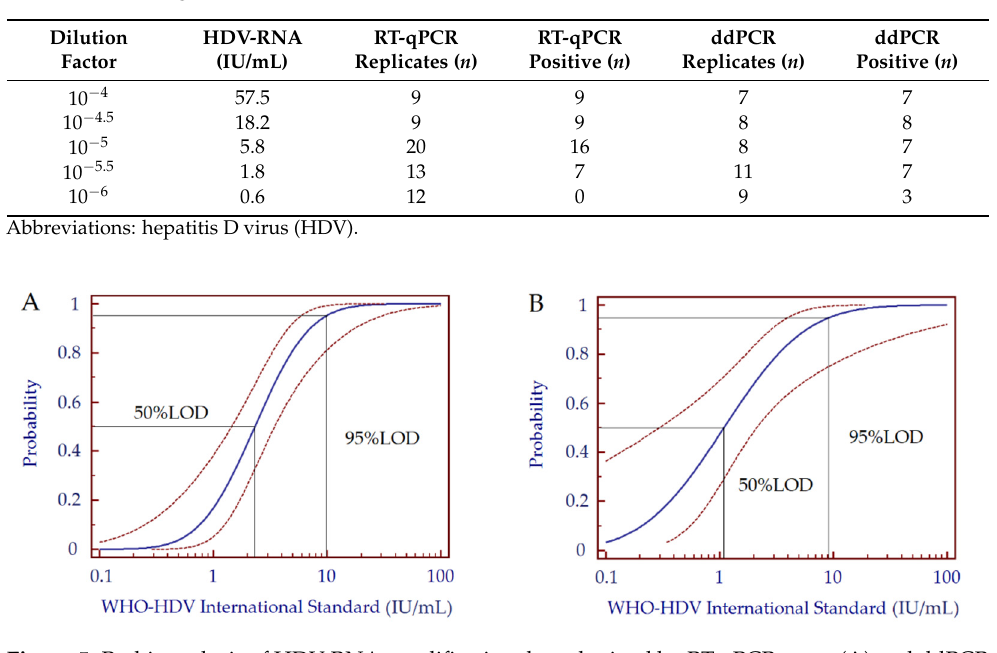
Table 4. Comparison of technical features between RT-qPCR and ddPCR.